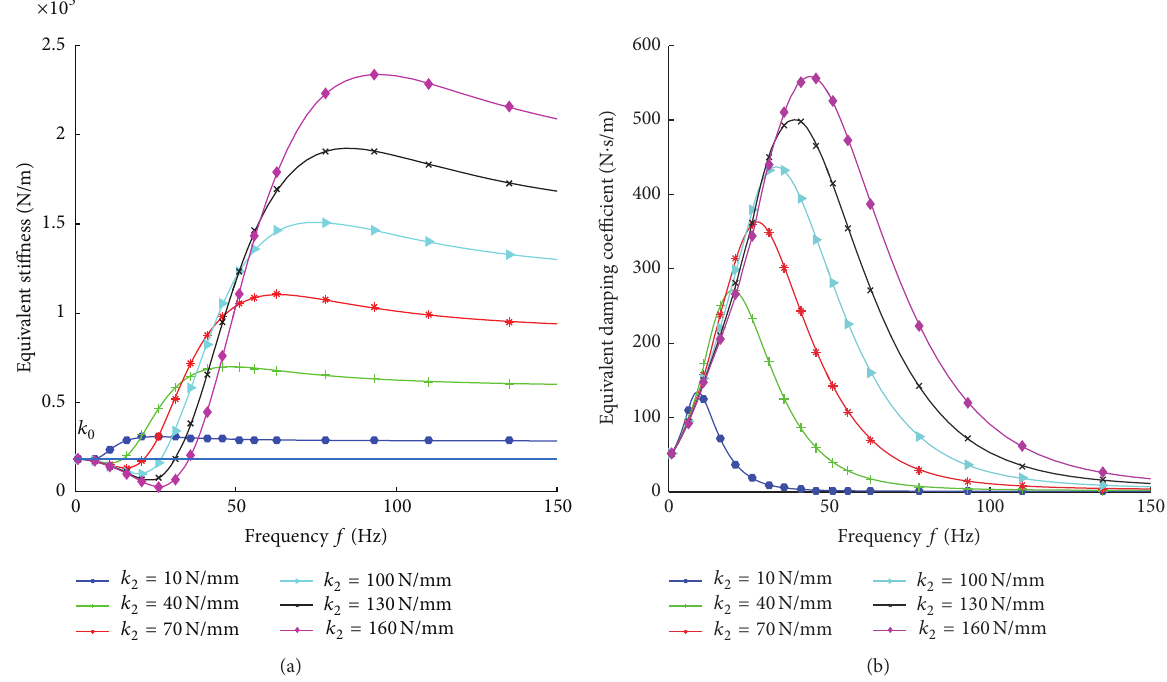
Figure 11: (a) Equivalent stiffness under different 𝑘 2 values. (b) Equivalent damping coefficient under different 𝑘 2